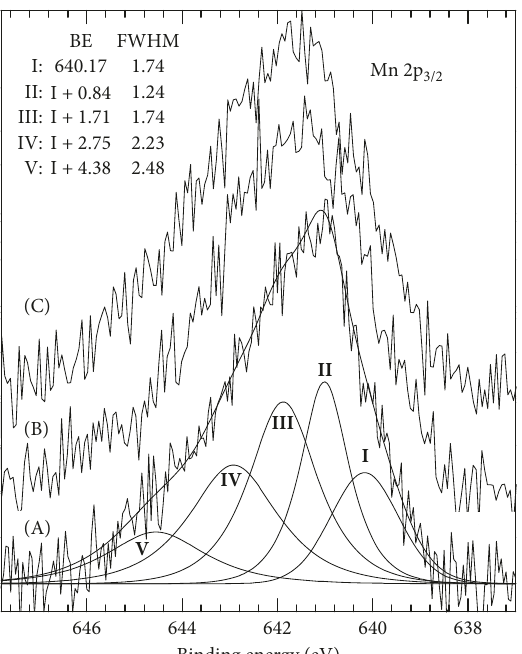
Figure 5: XPS photoelectron spectra of Mn 2p (A) P1-C2O4, (B) P2-CO3, and (C) P3-OH after their normali- zation in relation to the